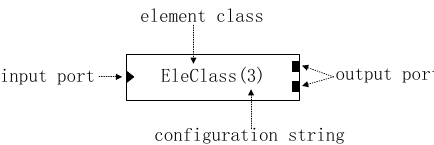
Figure 2. A sample element in